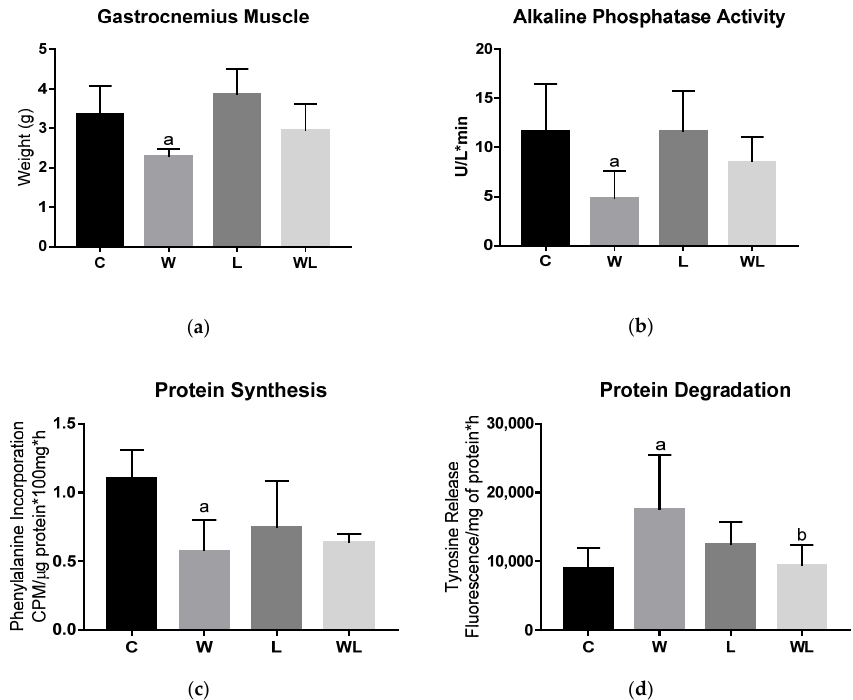
Figure 3. Tumour growth affected muscle protein synthesis and degradation and the phosphatase alkaline activity. ( a ) Muscle weight (g); ( b ) alkaline phosphatase activity, expressed as U/L*min; ( c ) muscle protein synthesis, expressed by the phenylalanine incorporation, CPM/µg protein*100 mg*h; ( d ) muscle protein degradation, expressed by tyrosine release, fluorescence/mg of protein*h. C, Control; W, Tumour-bearing animals; L, Group without tumour with a maternal leucine-rich diet; WL, Tumour-bearing group with a maternal leucine-rich diet. For details, see the Materials and Methods section. Values are presented as the mean ± SEM. n = 7, minimal animal per group. The data were analysed using a two-way ANOVA followed by the Bonferroni test to evaluate comparisons among groups. a p < 0.05, for comparison with the C group; b p < 0.05, for comparison with the W group.